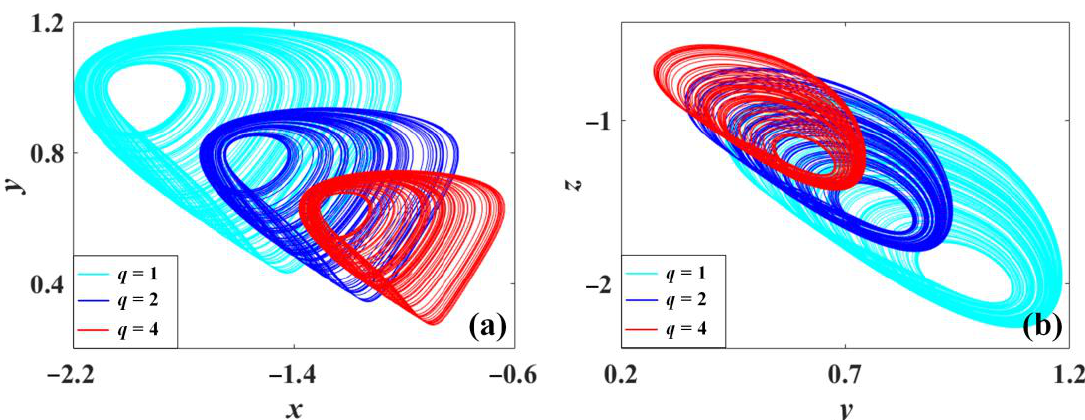
Figure 5. Chaotic oscillation of system (6) with a = 0.5, b = 1.1, and c = 1.2 under initial condition (0, 1, 1): ( a ) x-y , ( b ) y-z . ( p = 1 is cyan, p = 2 is blue, p = 4 is red.).